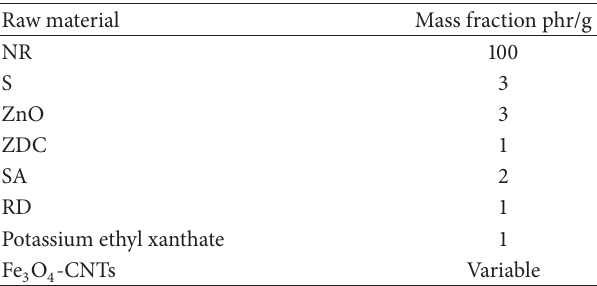
Table 1: Formula of Fe 3 O 4 -CNTs/NR